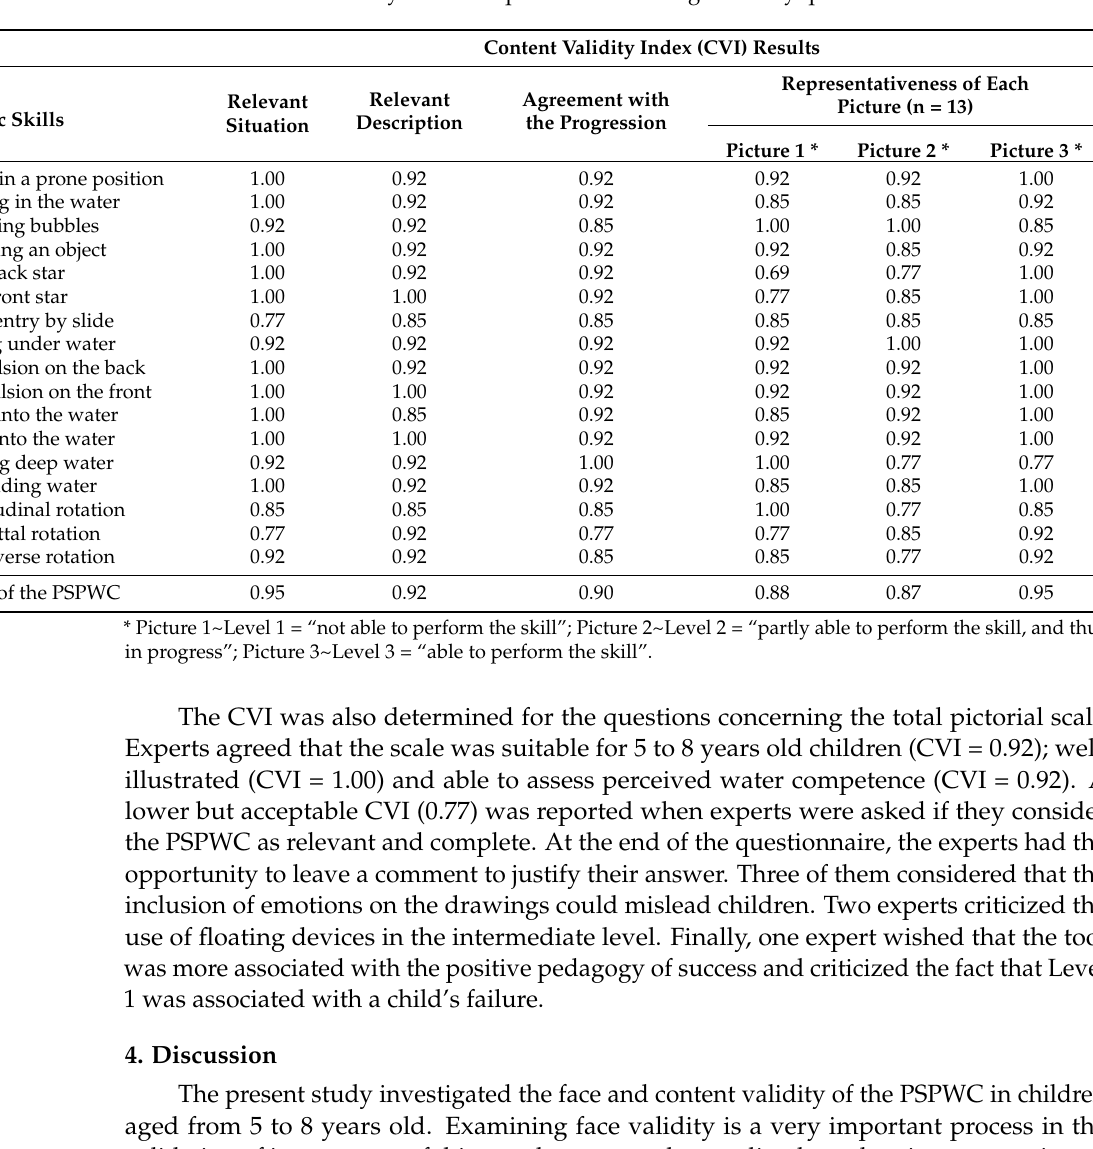
Table 5. Individual CVIs by item and question and average CVIs by